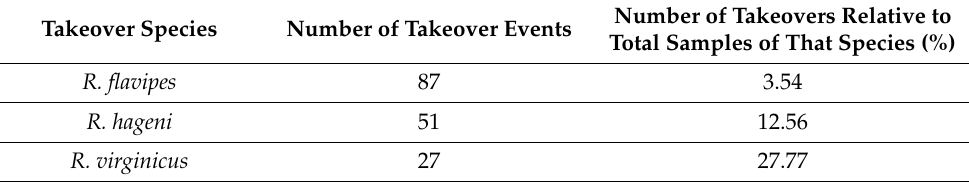
Table 2. Species turnover in consecutive months for Reticulitermes flavipes , R. hageni , and R. virginicus from September 2016 to August 2018. Takeovers occur when a species inhabits a monitor that was active with a different species the previous